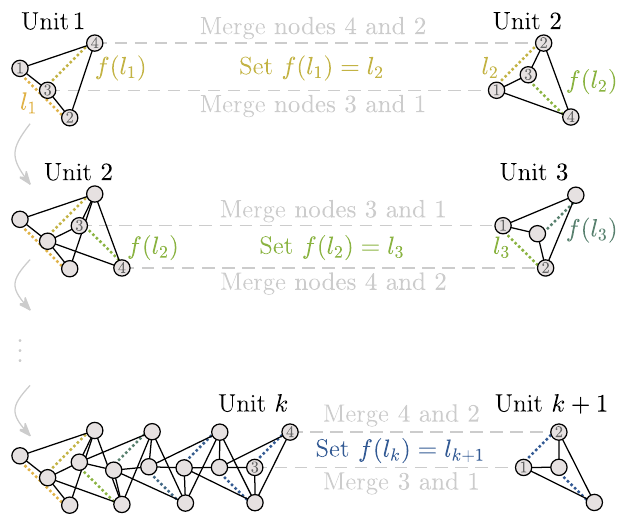
FIG. 4. Combine units by merging nodes. A unit k þ 1 is combined with unit k by merging nodes. First, the length l k þ 1 between nodes 1 and 2 of unit k þ 1 is set equal to the length f ð l k . Then, node 2 of unit k þ 1 k Þ between nodes 3 and 4 of unit is merged to node 4 of unit k by overlapping and gluing the nodes such that they become the same node, and node 1 of unit k þ 1 is merged to node 3 of unit k in the same